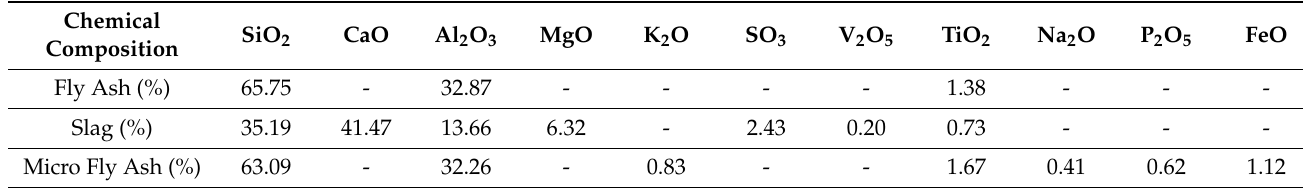
Table 1. Chemical composition of binder materials [4].